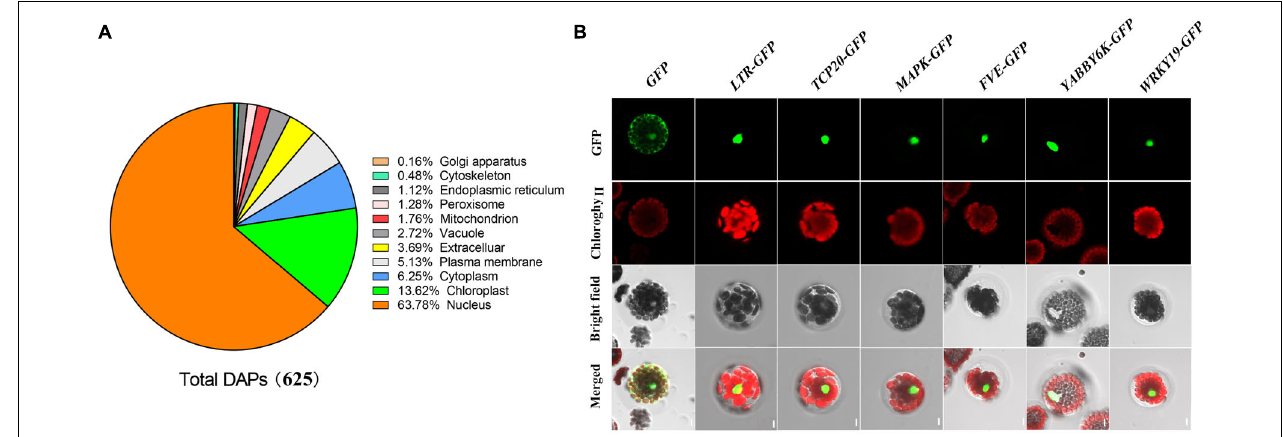
FIGURE 2 | Subcellular localization of differentially accumulated proteins identified under water deficit. (A) Subcellular localization of differentially accumulated proteins in wheat developing grains under drought stress. (B) Subcellular localization of six reprehensive proteins by wheat protoplast transformation. GFP, GFP fluorescence; Chlorophyll, chlorophyll autofluorescence; Bright field, the field of bright light; Merged, merged GFP fluorescence, chlorophyll autofluorescence, and the field of bright light. LTR, low temperature-responsive RNA-binding protein; TCP20, TCP20 transcription factors; MAPK, mitogen-activated protein kinase; FVE,WD-40 repeat-containing protein; YABBY6, transcription factor YABBY6; and WRKY, transcription factor WRKY.